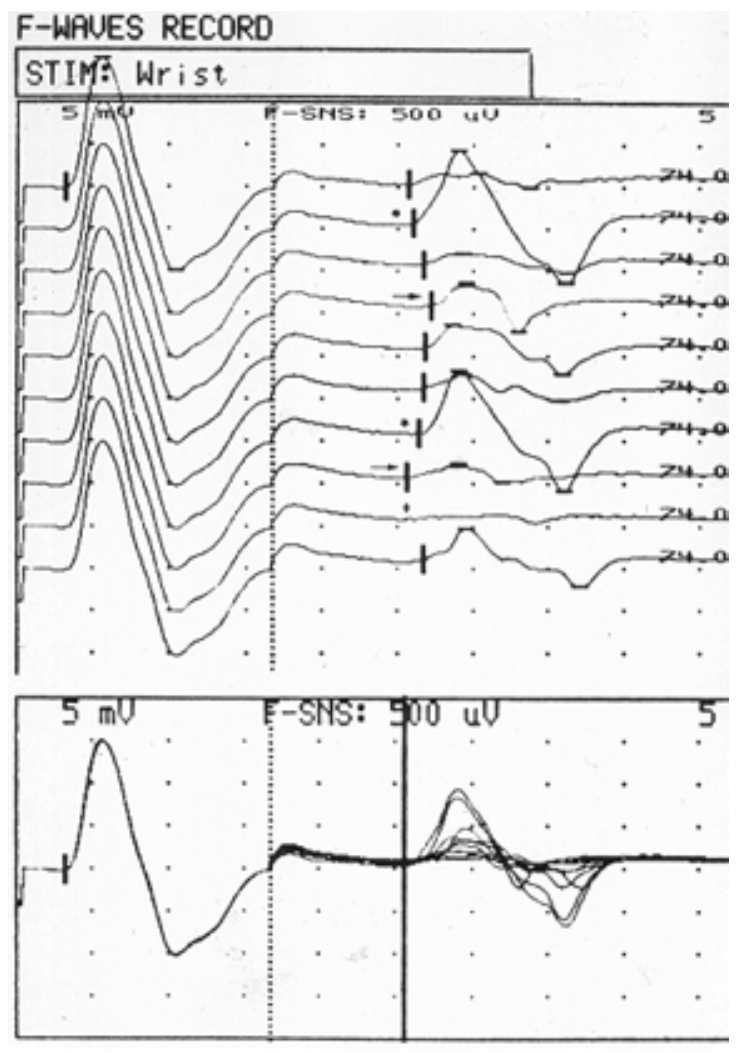
Figure1. F-waves (right) with the associated M-waves (left). The variability of F-waves is emphasized with the responses superimposed as shown below. Chronodispersion is the difference between the shortest and longest latencies. The persistence is 90%, i.e. one of the ten responses is absent. The two largest F-waves are repeater waves. Calibration per division: 5 mV for M waves, 500 μ V for F-waves; 5 ms. (Reproduced with permission, Fisher et al.,